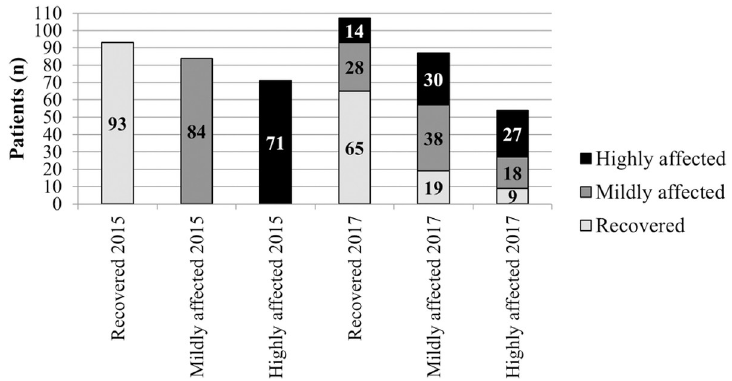
Fig 1. The Curac¸ao long-term Chikungunya sequelae classification score of the cohort (n = 248). The chikungunya disease status of the cohort during baseline in 2015 and follow-up in 2017 using the Curac¸ao long-term chikungunya sequelae score. The colors refer to the chikungunya disease status in 2015. Groups were compared using McNemar- Bowker test, two-sided P-value = .12.